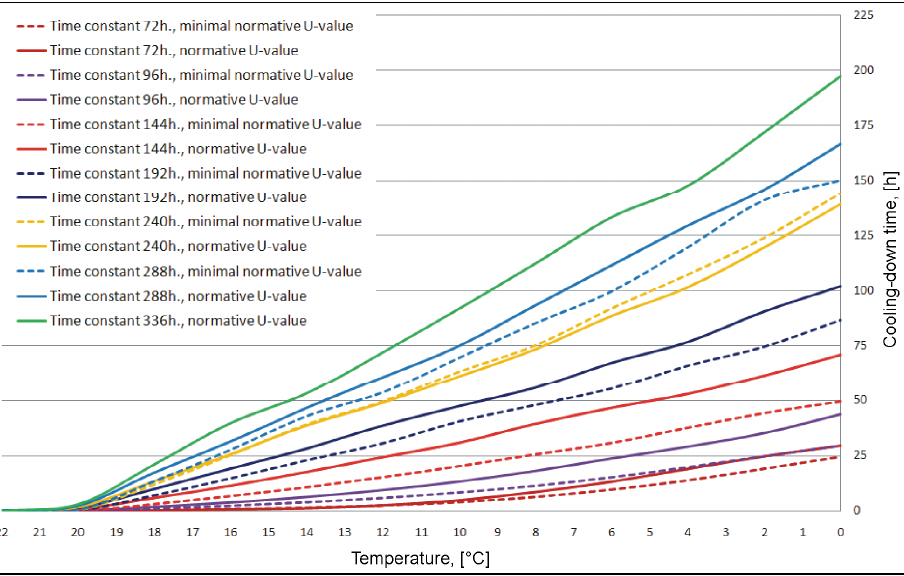
Fig. 4. Curves of building cooling-down at “extreme” outdoor temperature